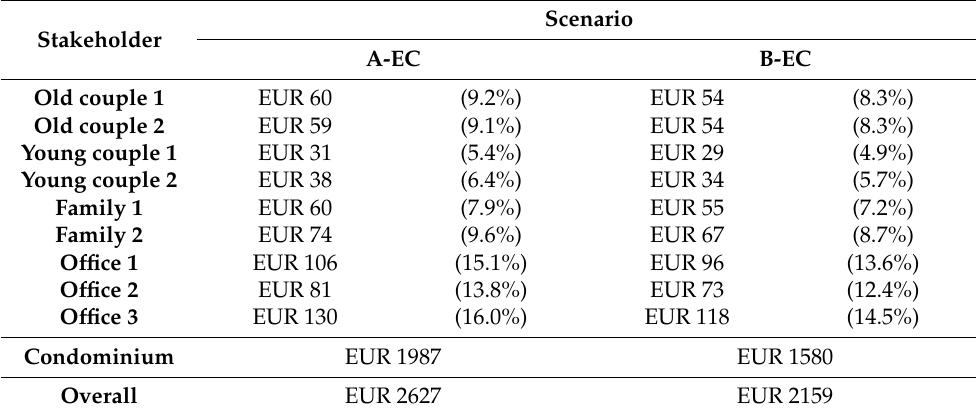
Table 8. Yearly revenue of each stakeholder of the configuration for Scenario A-EC and Scenario B-EC (for passive members, the percentage on their yearly electricity bill is reported).